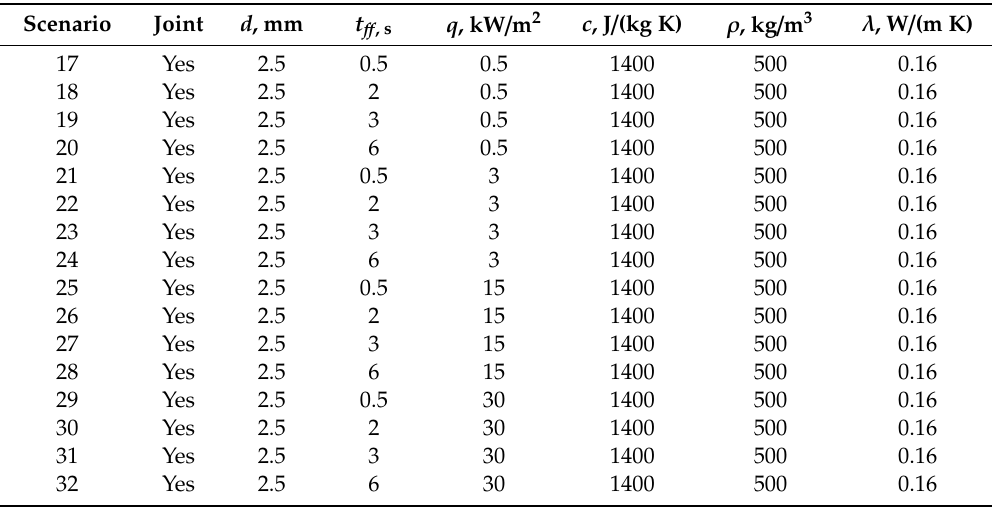
Table A5. The Main Scenarios of Forest Fire Impact on a Stem with a Joint. Part